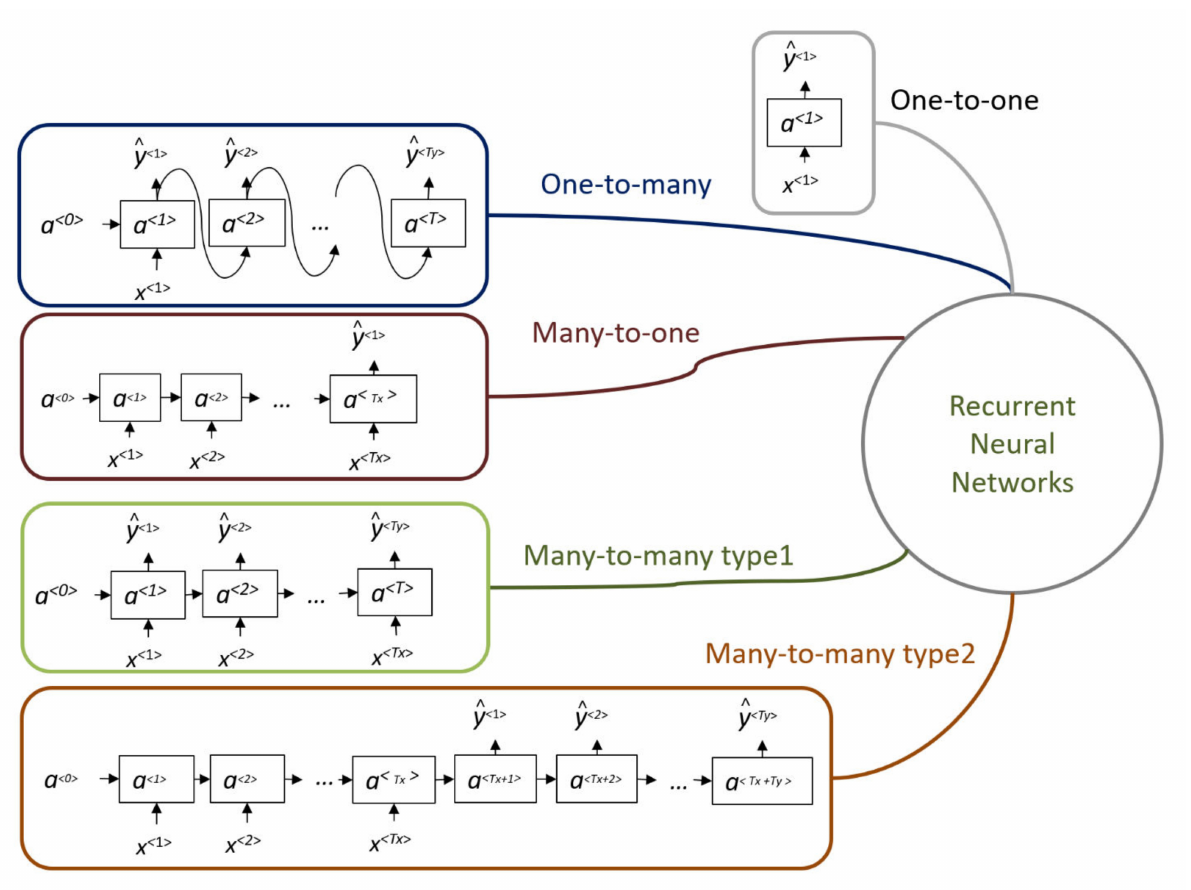
Figure 6. Recurrent neural networks. Source: generated by the